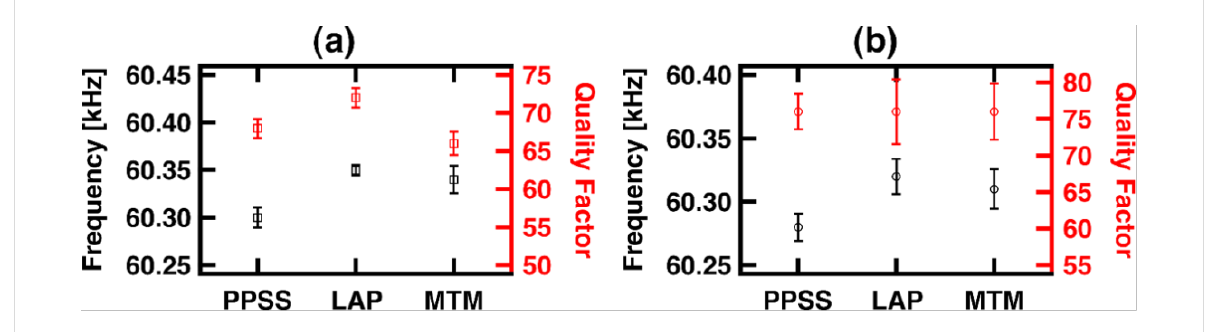
Figure 2: Summary of mechanical parameters for all samples, obtained using CRFM: (a) thick and (b) thin samples. Average frequency and quality factor values were obtained by fitting a Gaussian distribution to a histogram of the images. The one-standard-deviation range is also shown.